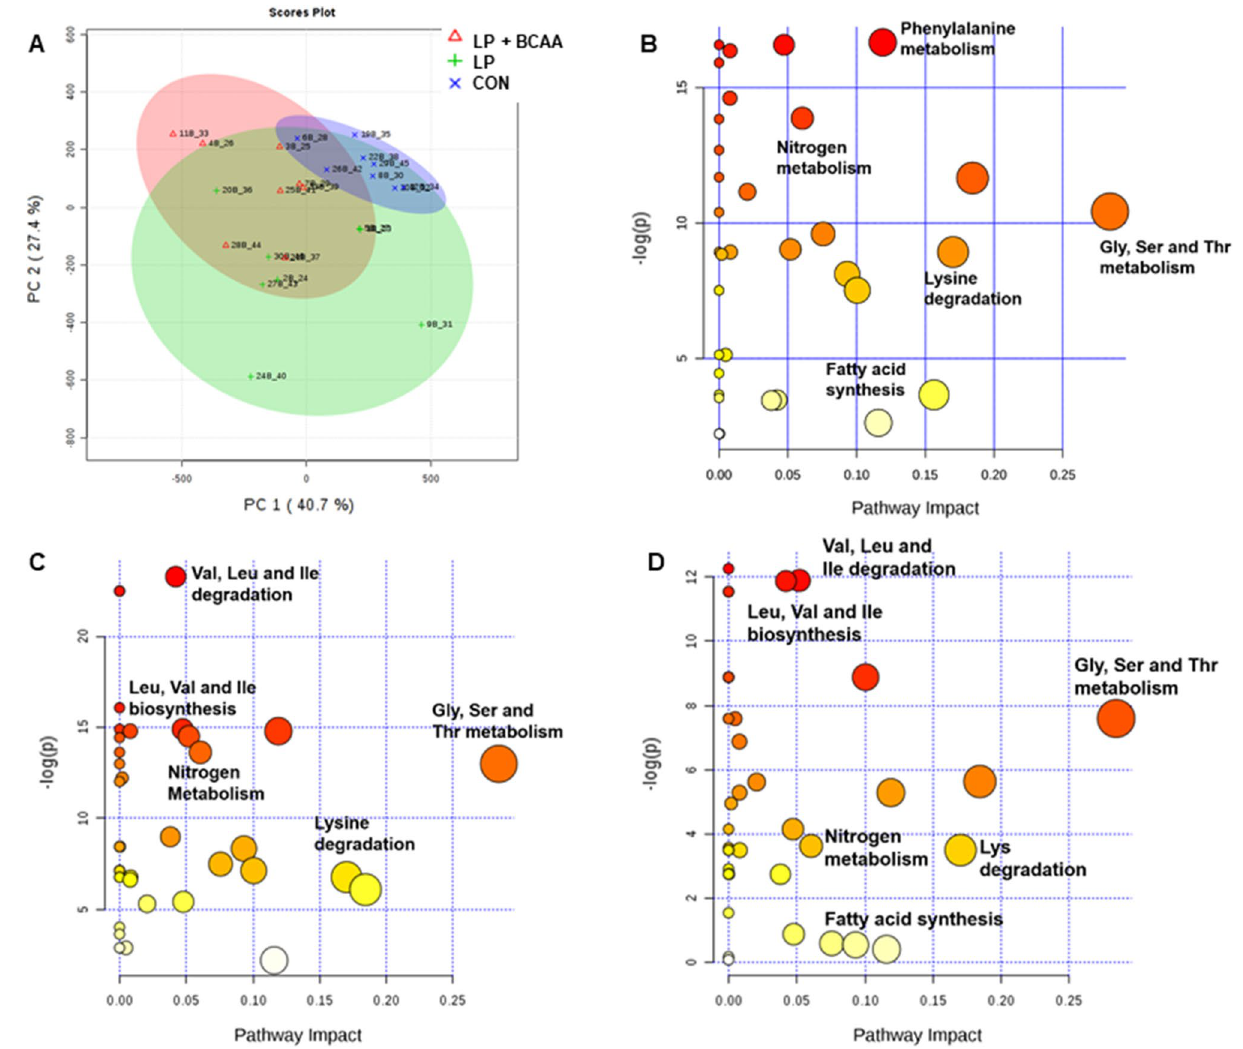
Figure 3. Principal component analysis (PCA) score plots and the pathway analysis map of plasma metabolites in pigs fed with very low protein diets supplemented with branched-chain amino acids. ( A ) PCA score plot for plasma metabolites. Individual pigs are shown as nodes, ( B , C , D ) the map of pathway analysis for the plasma. Each circle is obtained from topology analysis representing a metabolic pathway with the scores. The x-axis denotes the pathway impact and the y-axis represents the pathway enrichment. The size of each circle is based on its impact value while the color of each circle is based on its P value. Larger size circles have higher pathway impact, while darker color circles are indicative of more significant changes of metabolites and pathway enrichment. CON, control diet; LP, low protein diet; LP + BCAA, low protein diet supplemented with branched- chain amino acids. ( B ) CON vs. LP + BCAA, ( C ) CON vs. LP, ( D ) LP vs. LP + BCAA. n =